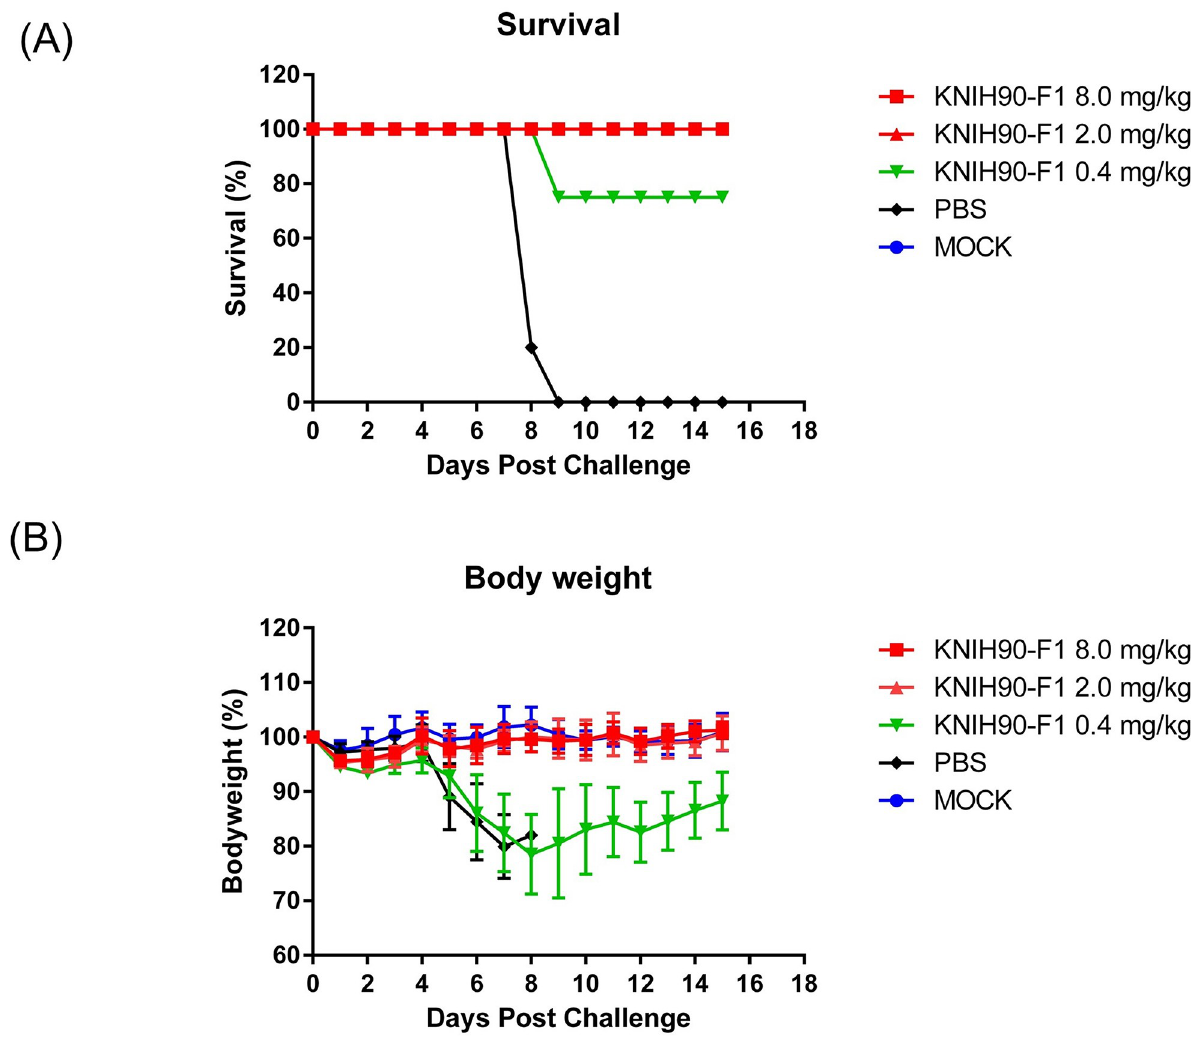
Fig 4. MERS-CoV RBD-specific mAb protects mice from lethal challenge. Five hDPP4 TG mice were intraperitoneally administered different doses of KNIH90-F1 24 h after intranasal inoculation with the MERS-CoV KNIH-002 strain (1 × 10 5 pfu/30 μ l). Body weight change (A) and survival (B) were monitored for 14